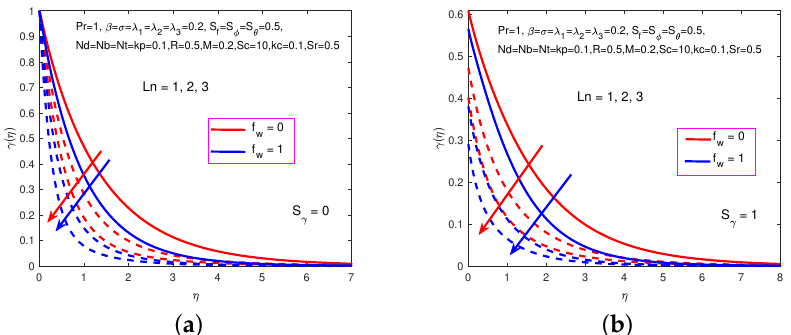
Figure 13. Influence of Ln and f w on γ . ( a ) No nanoparticles concentration slip. ( b ) With nanoparticles concentration slip.